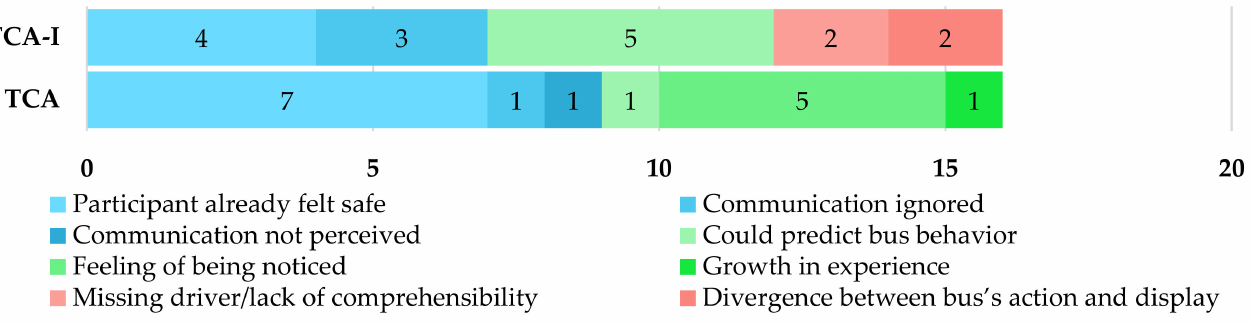
Figure 6. Sense of safety: distribution of results according to test condition. (Interview question